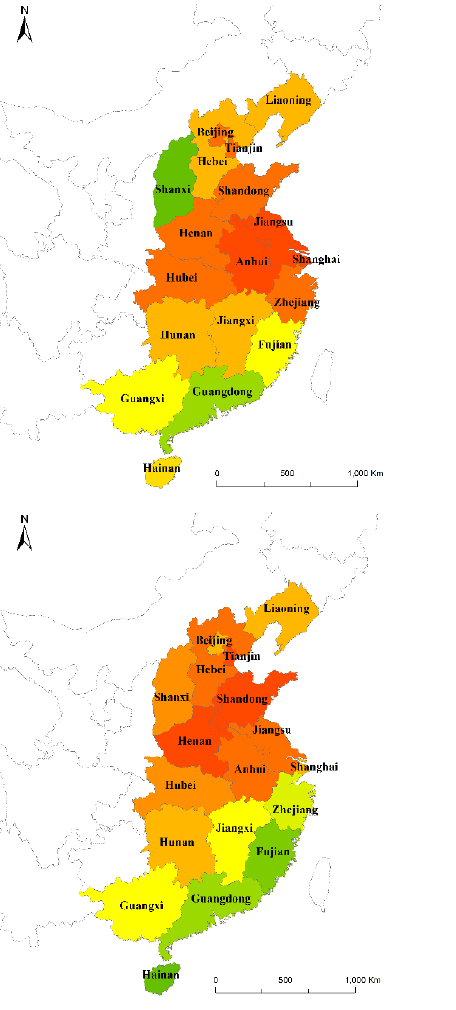
Figure 3. PM (cid:2870).(cid:2873) concentrations. Figure 3. PM 2.5